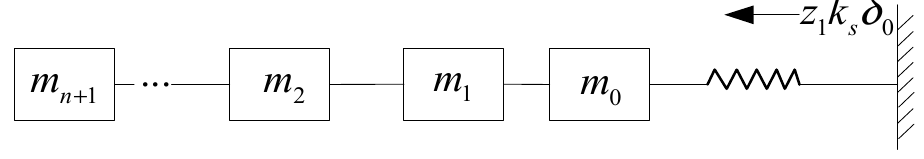
Figure 7. Equivalent model of the piston and N pairs of friction pairs